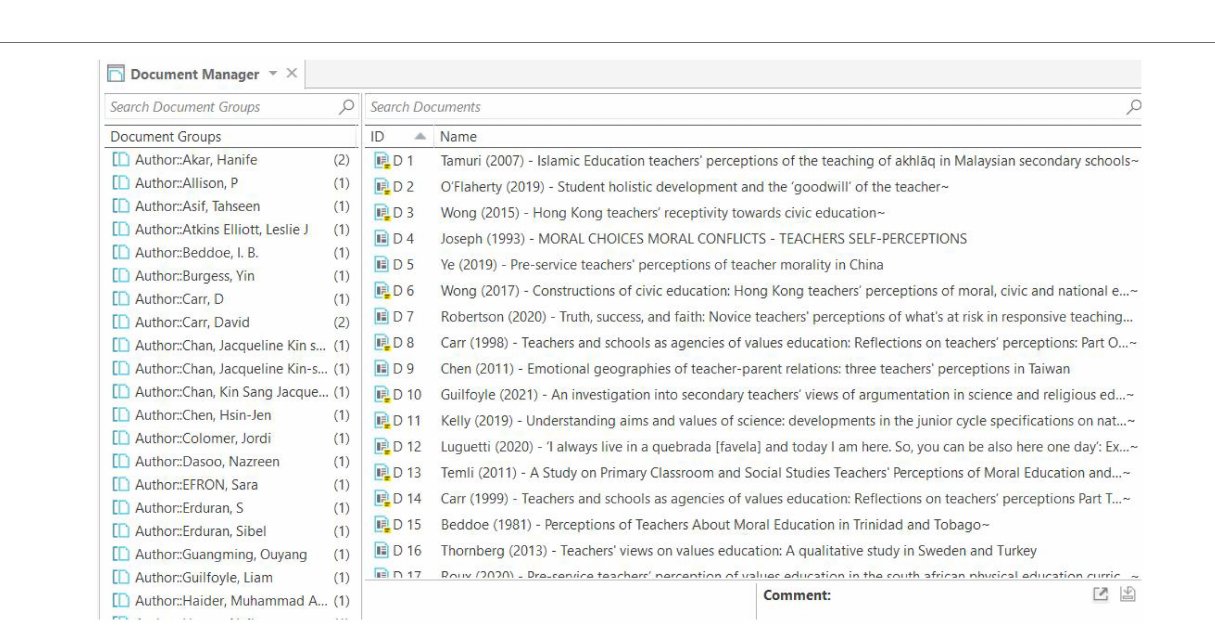
FIGURE 2 | Metadata generated in ATLAS.ti Scientific Software Development GmbH [ATLAS.ti 9 Windows] (2022). We used ATLAS.ti Windows (Version 9.1.3.0) to complete our work. Reproduced with